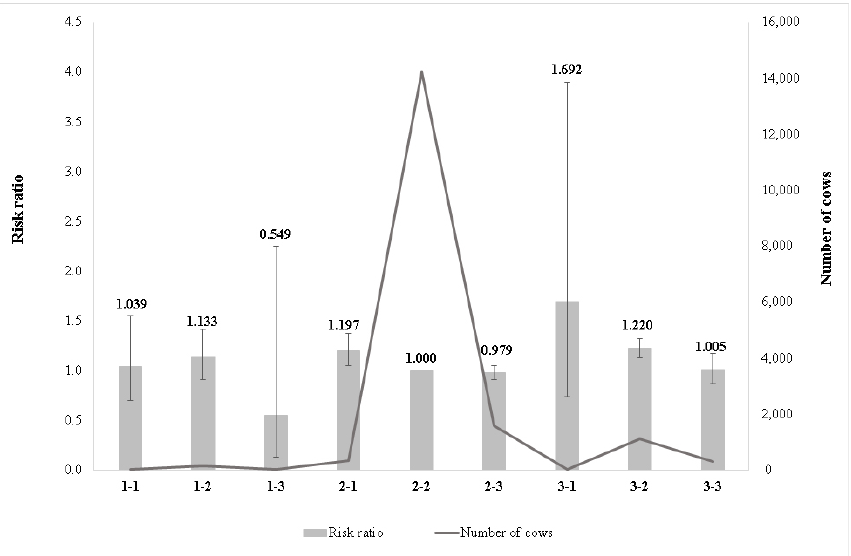
Figure 4. Effect of combination of angularity and rear udder height on the relative culling risk. 1-1 : lacks angularity–low rear udder height; 1-2 : lacks angularity–intermediate rear udder height; 1-3 : lacks angularity–high rear udder height; 2-1 : intermediate angularity–low rear udder height; 2-2 : intermediate angularity–intermediate rear udder height; 2-3 : intermediate angularity–high rear udder height; 3-1 : very angular–low rear udder height; 3-2 : very angular–intermediate rear udder height; 3-3 : very angular–high rear udder height